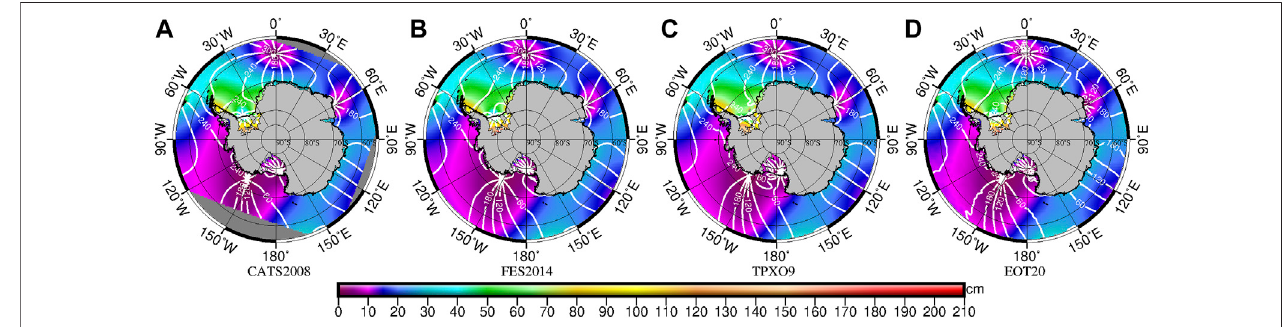
FIGURE2| CotidalchartoftheM2constituentof (A) CATS2008, (B) FES2014, (C) TPXO9,and (D) EOT20.Grayvaluesin (A) arelocationsbeyondthegeographic coverage of CATS2008. The color scale represents the amplitude value; white contour lines represent the phase lag ( ° ).